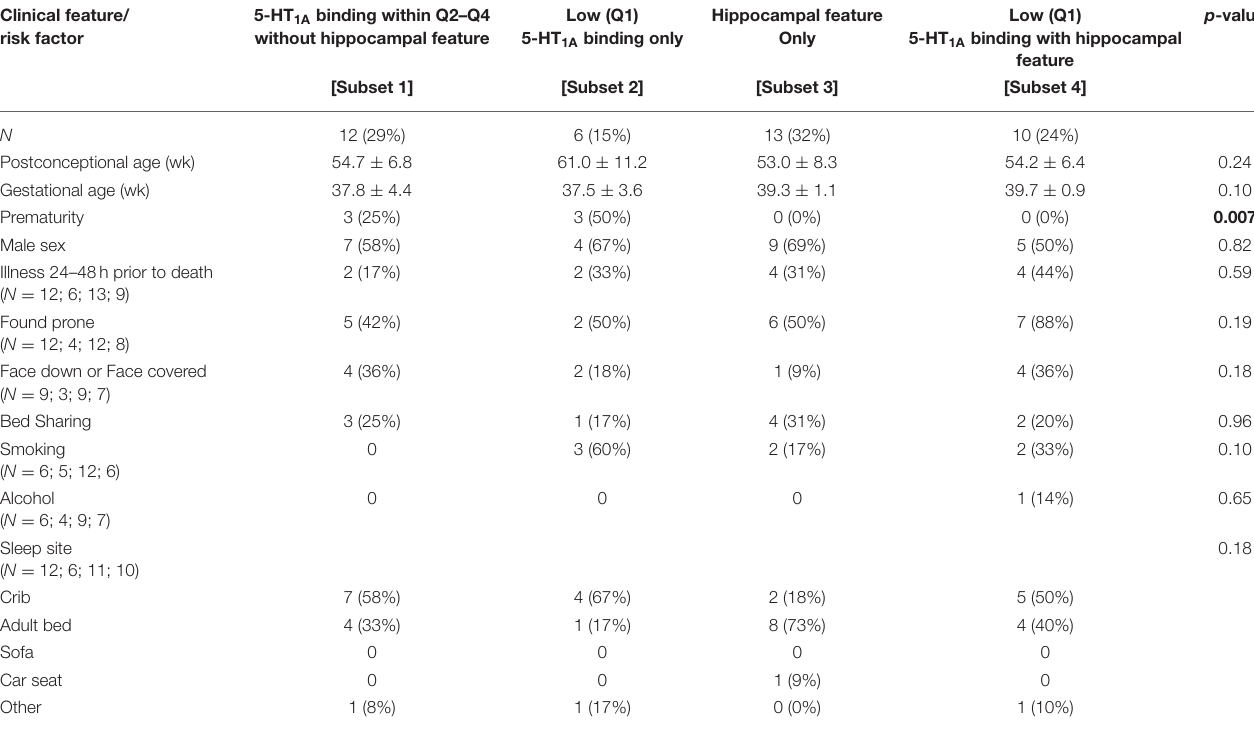
TABLE 7 | Clinical and risk factor profile by medullary 5-HT 1A binding and hippocampal feature (focal granule cell bilamination) status. Clinical feature/ risk